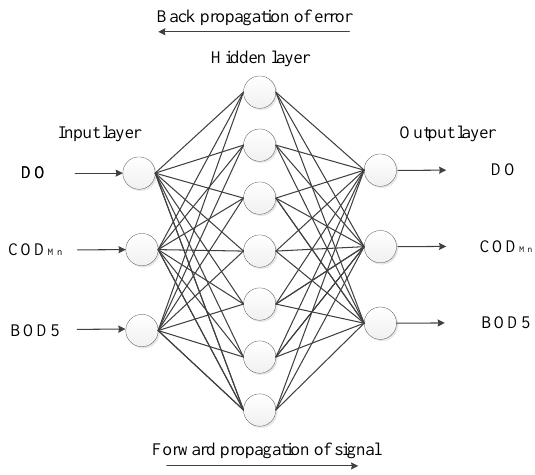
Figure 5. The 3-7-3 BP neural network model.